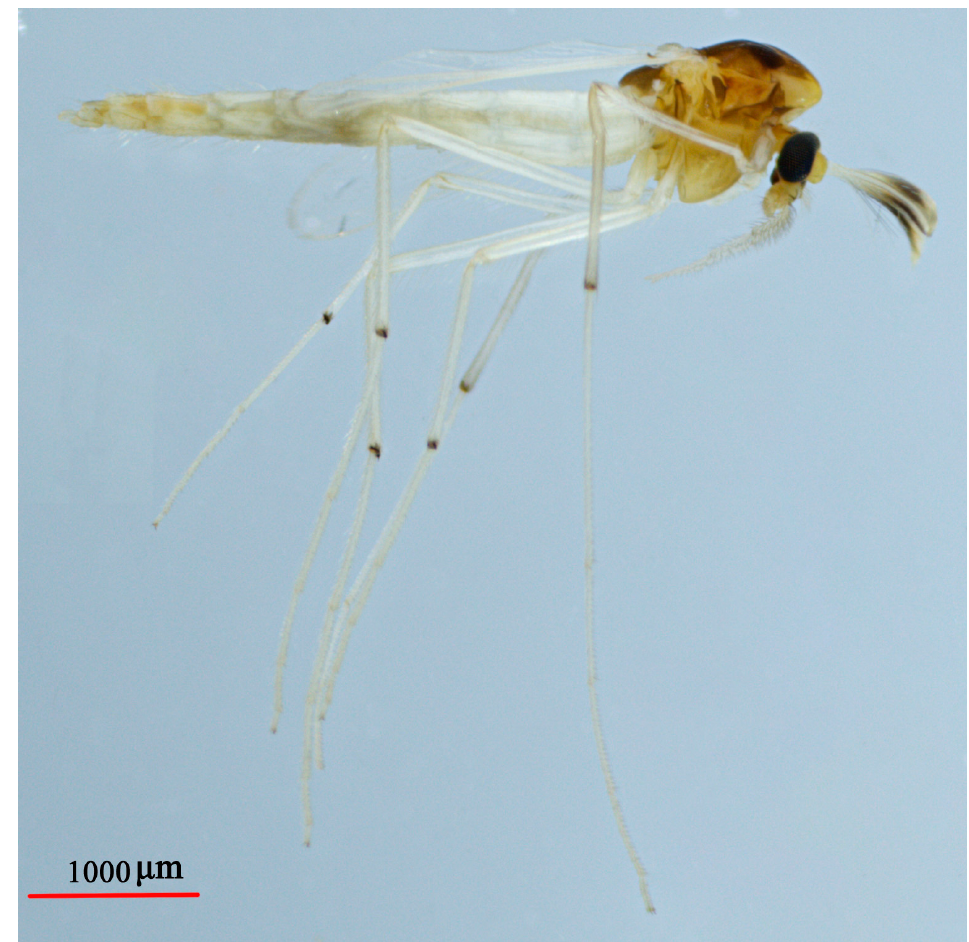
Figure 4. Male adult (holotype, in lateral view) of Microtendipes baishanzuensis sp. nov. Type material. Holotype: male (Sample ID: ZJCH072, Field ID: BSZ27), China,